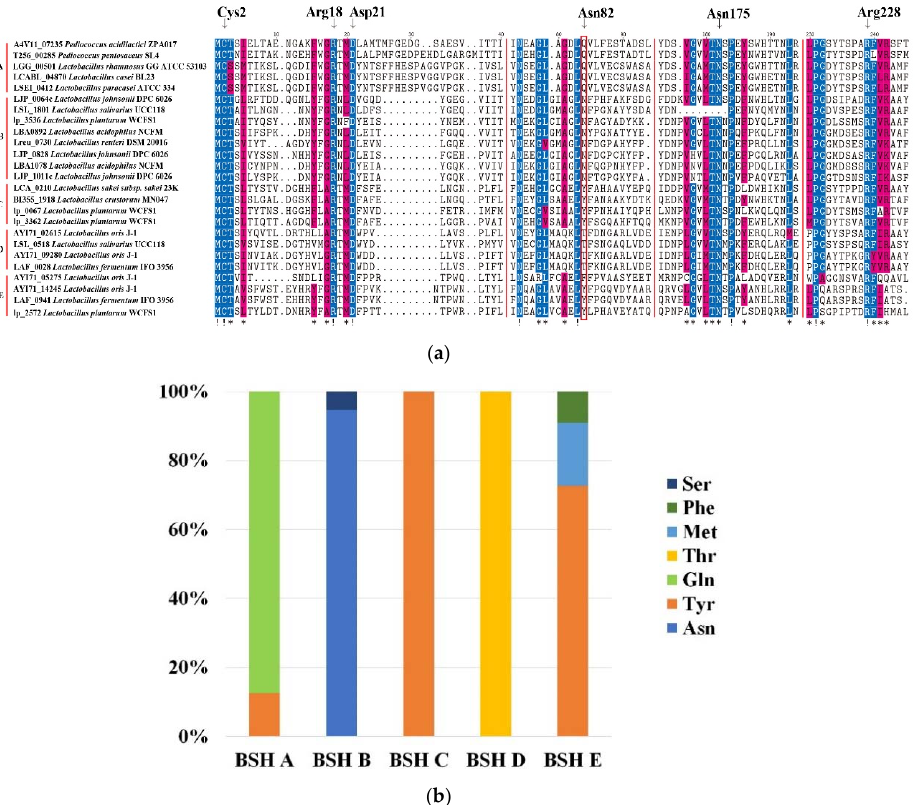
Figure 3. Analysis of catalytic residues of BSH proteins. ( a ) Multiple-sequence alignment of five BSH subtypes in representative species. Six catalytic residues are marked by top arrow, and the site 82 is highlighted by the red box. The residues with sequence identity >50% and >80% were shaded by blue and yellow blocks, respectively; “!” and “*” were noted in the bottom side which residues identity =100% and >80%, respectively. ( b ) amino acid statistics of site 82 in six BSH subtypes from all BSH–SDL sequences (see more details of other sites in Table